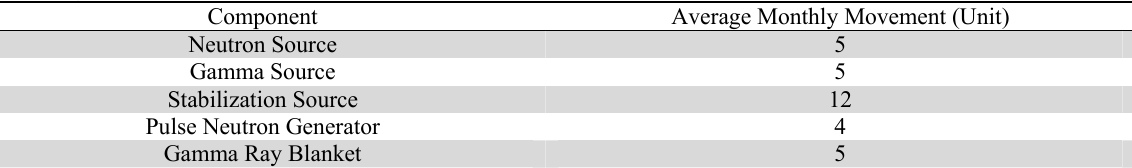
Monthly Movement (Unit) in 2014 and 2015 Component